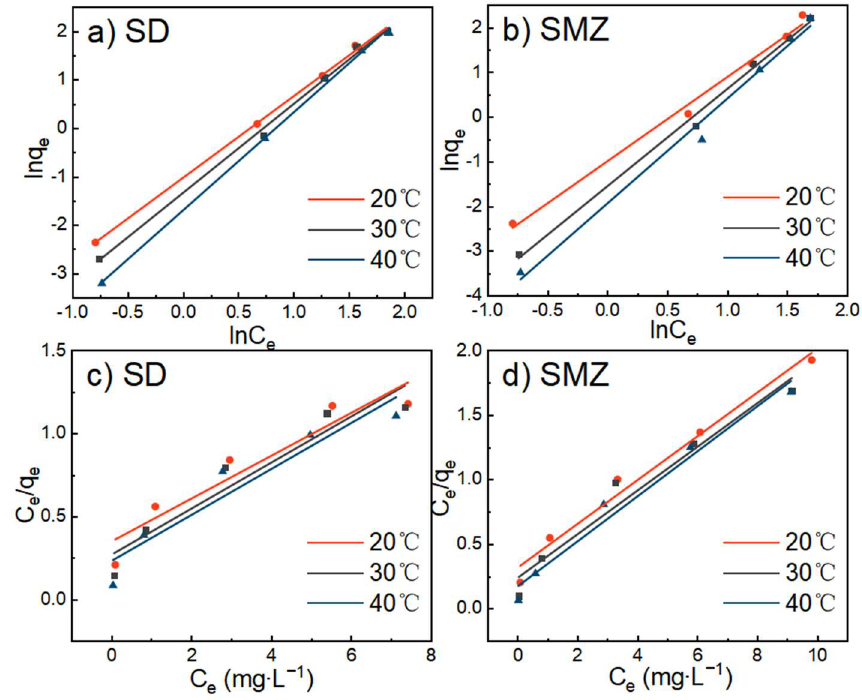
Figure 8. Freundlich ( a , b ) and Langmuir ( c , d ) isotherms of sulfonamide adsorption by ATP/BC-0.1. Table 3. Isotherm parameters for the adsorption of sulfonamide by ATP/BC-0.1. Freundlich Isotherm Langmuir Isotherm Sulfonamides Temperature